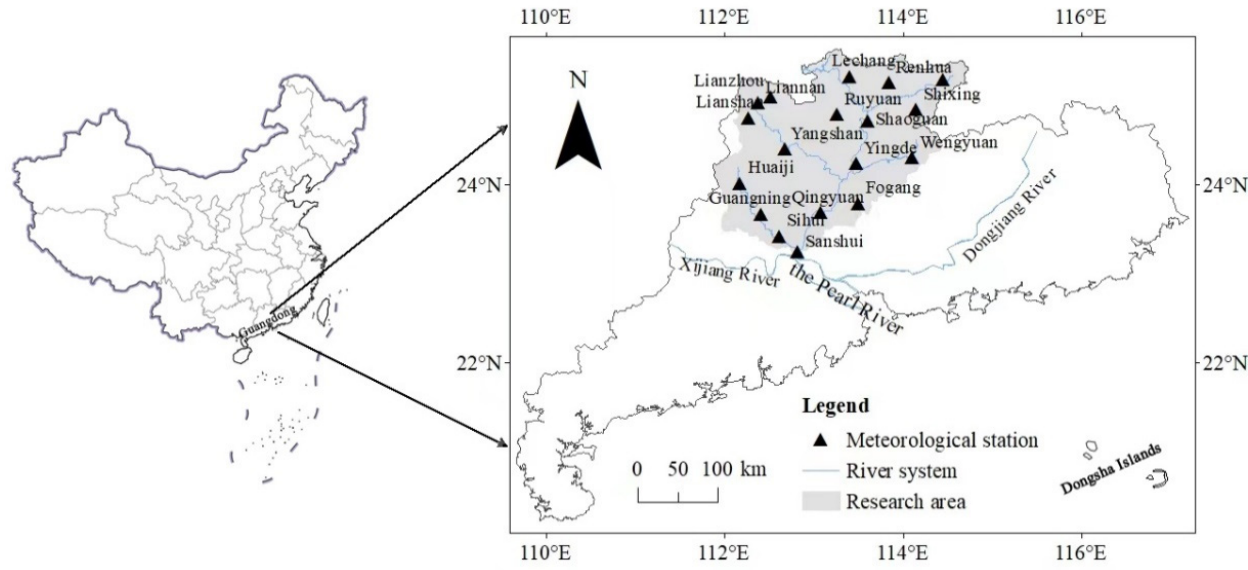
Figure 1. The location of the Beijiang River Basin in South China and 18 rain-gauge stations in this area.